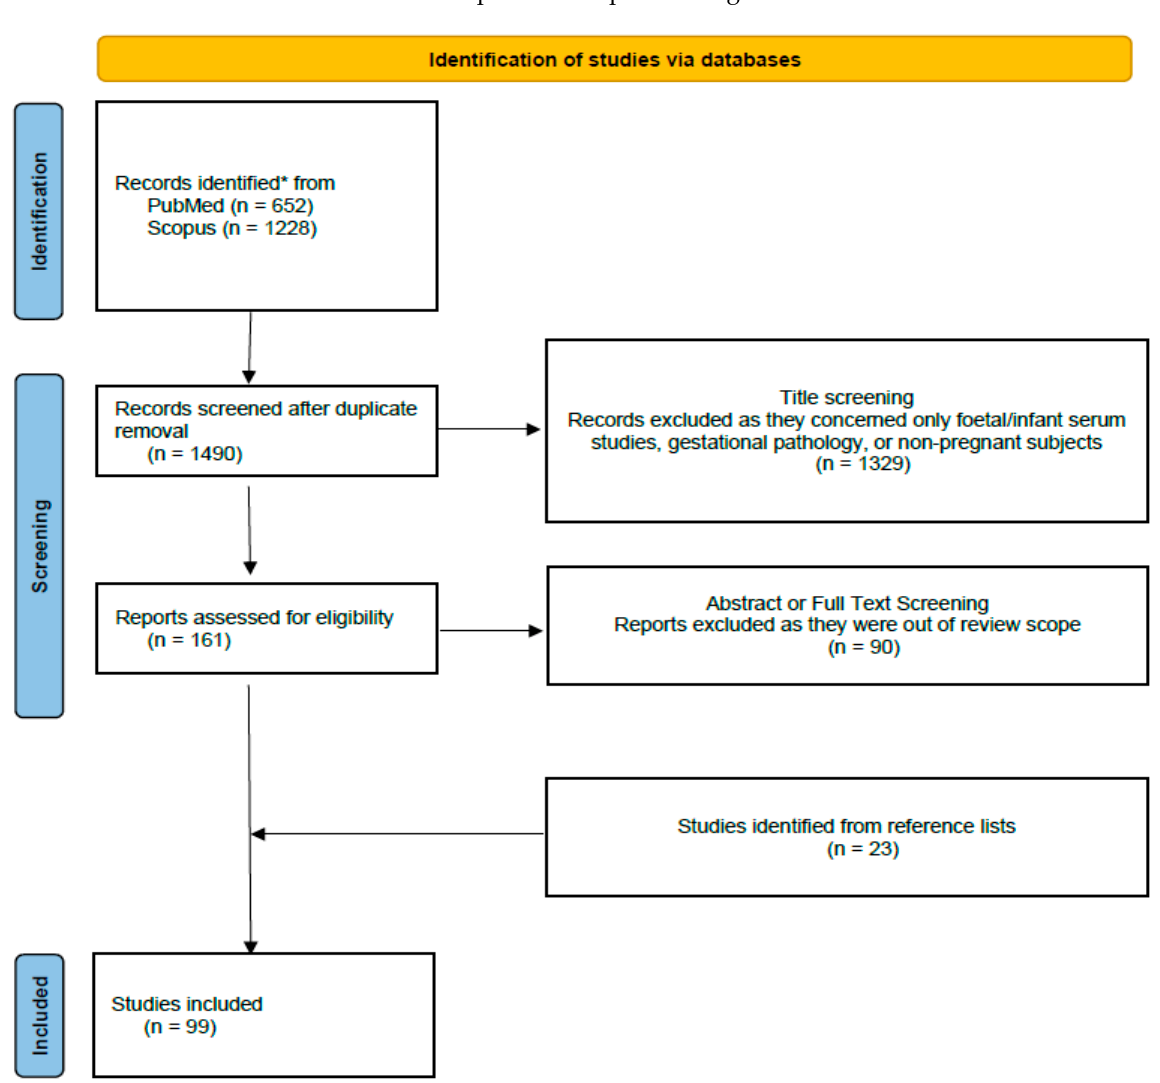
Figure 1. Study flowchart [29] *(((“maternal bone molecules” OR “maternal bone markers” OR “ma- ternal bone biomarkers” OR “maternal bone metaboli*” OR sclerostin OR sRANKL OR “soluble recep- tor activator of nuclear factor- κ B ligand” OR osteocalcin OR osteoprotegerin OR “25-hydroxyvitamin D3” OR “cholecalciferol” OR “Vitamin D”) AND (“fetal growth” OR “fetal metaboli*” OR “birth anthropometr*” OR “birth weight” OR “offspring metaboli*”))).